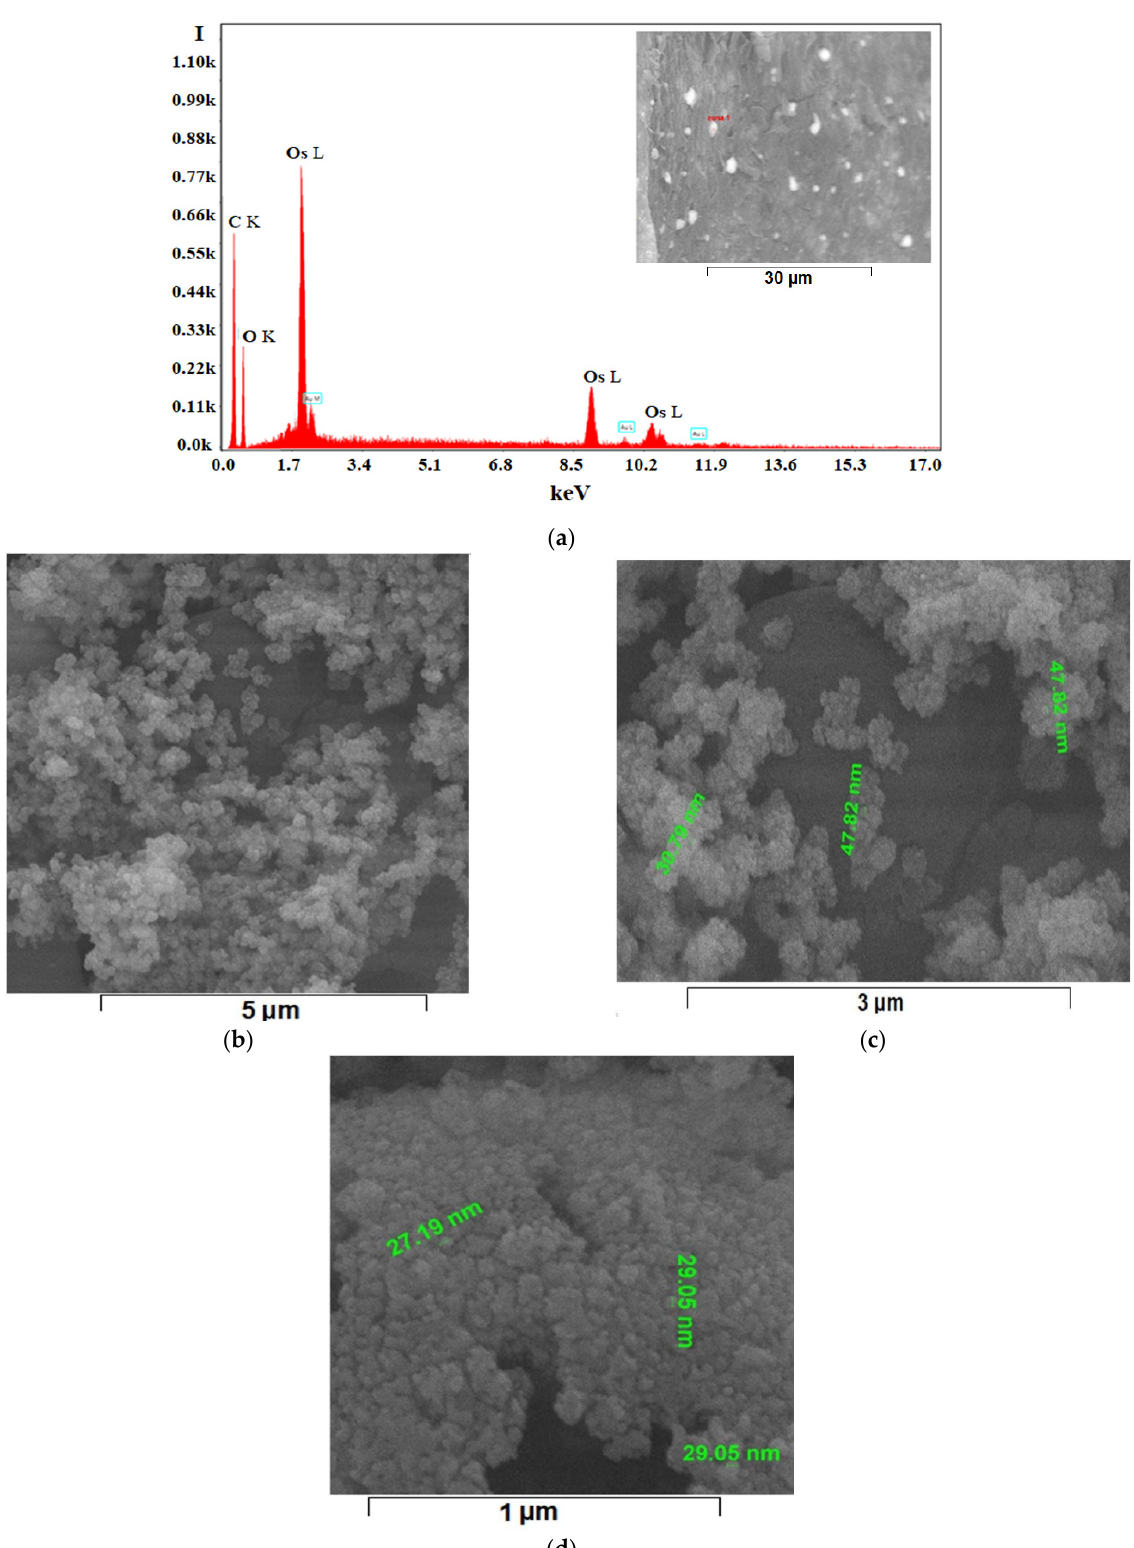
Figure 8. Formal energy dispersive spectroscopy analysis (EDAX) for the raw osmium nanoparticles-polypropylene hollow fibers composite membrane (Os-PP) ( a ), and high-resolution scanning electron microscopy (HR-SEM) of the specific osmium nanoparticles distribution on raw membrane surface: ×20,000 ( b ); ×50,000 ( c ); and ×100,000 ( d ).